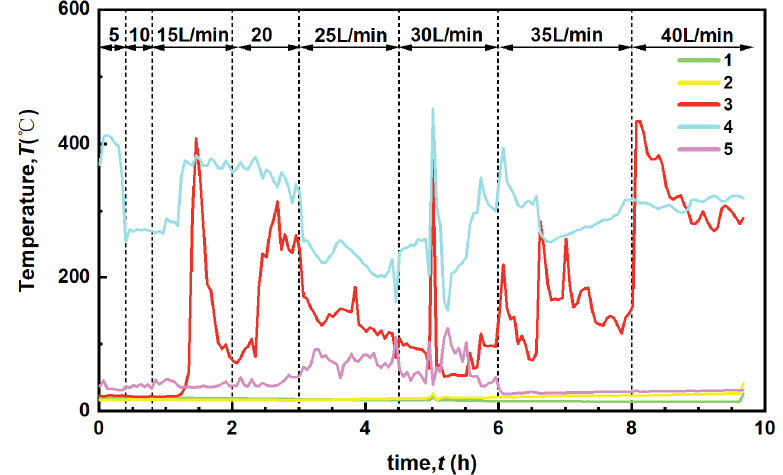
Figure 4. History of measured temperature at different positions.